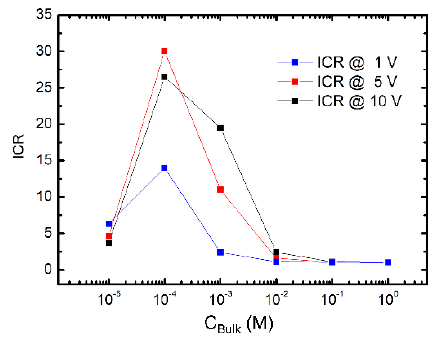
Figure 12. Current I normalized with respect to C Bulk as a function of the applied voltage V, for different values of C Bulk : 1 M (black squares), 10 −1 M (pink), 10 −2 M (blue), and 10 −3 M (red).